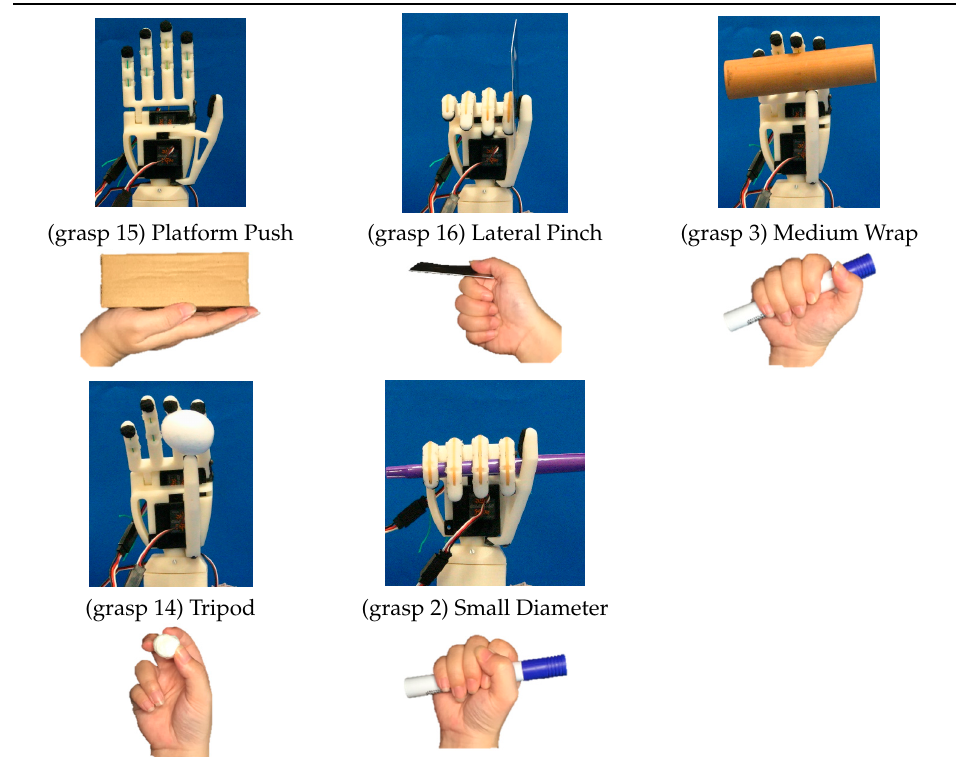
Table 6. Achievable motion types (stable linkage type).